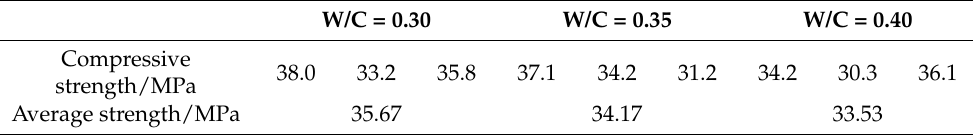
Table 6. Compressive strength of